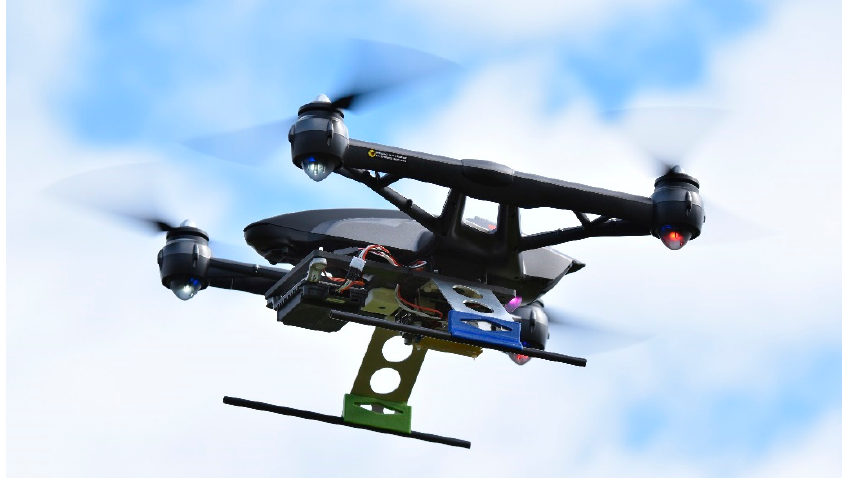
Figure 5. Test flight to check the measurement system with radar sensor ARS-404.